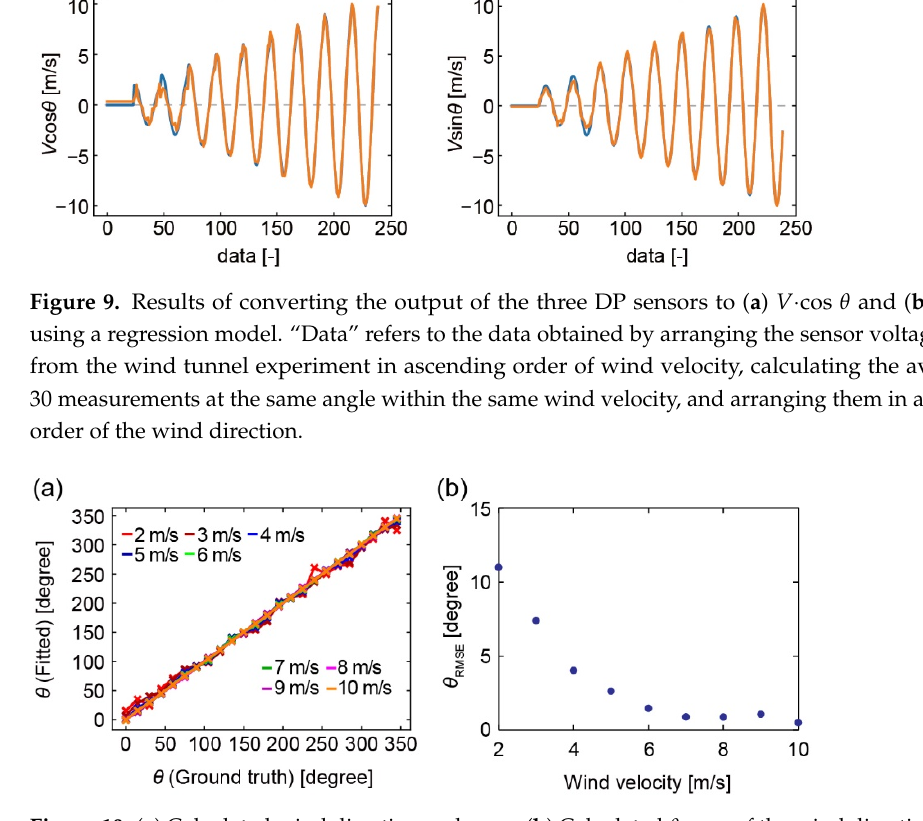
Figure 10. ( a ) Calculated wind direction and error. ( b ) Calculated θ RMSE of the wind direction against the wind velocity.